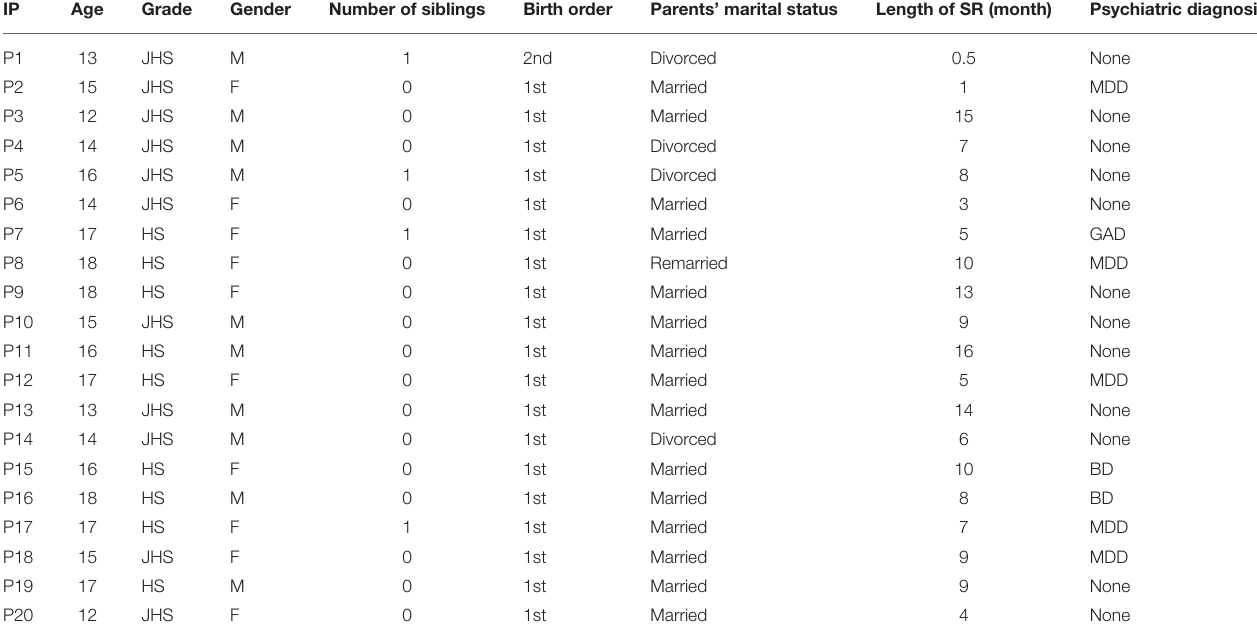
TABLE 1 | Characteristics of the participants.